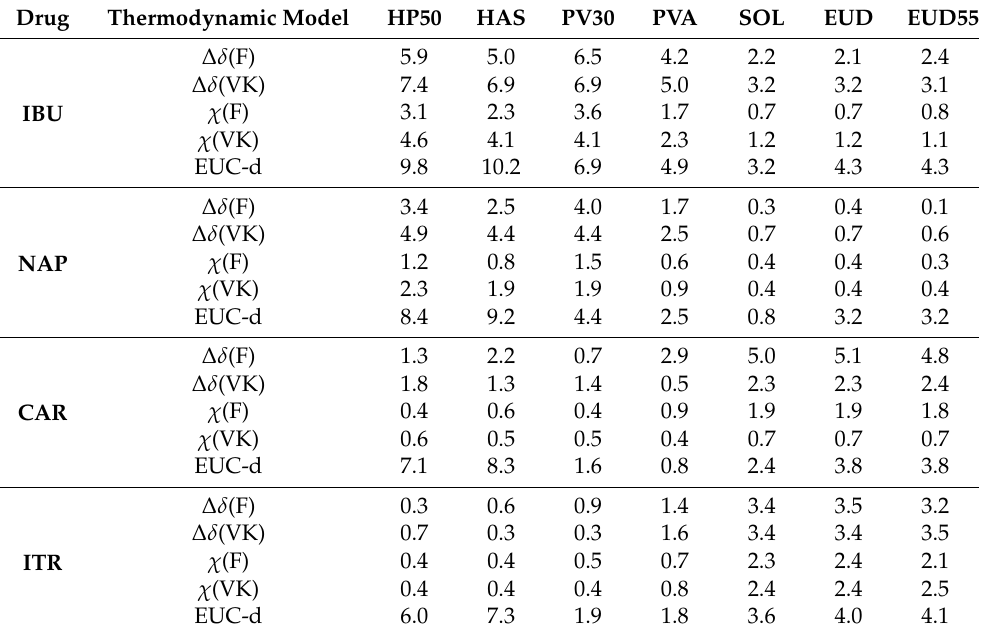
Summary of thermodynamic model calculations: solubility parameters